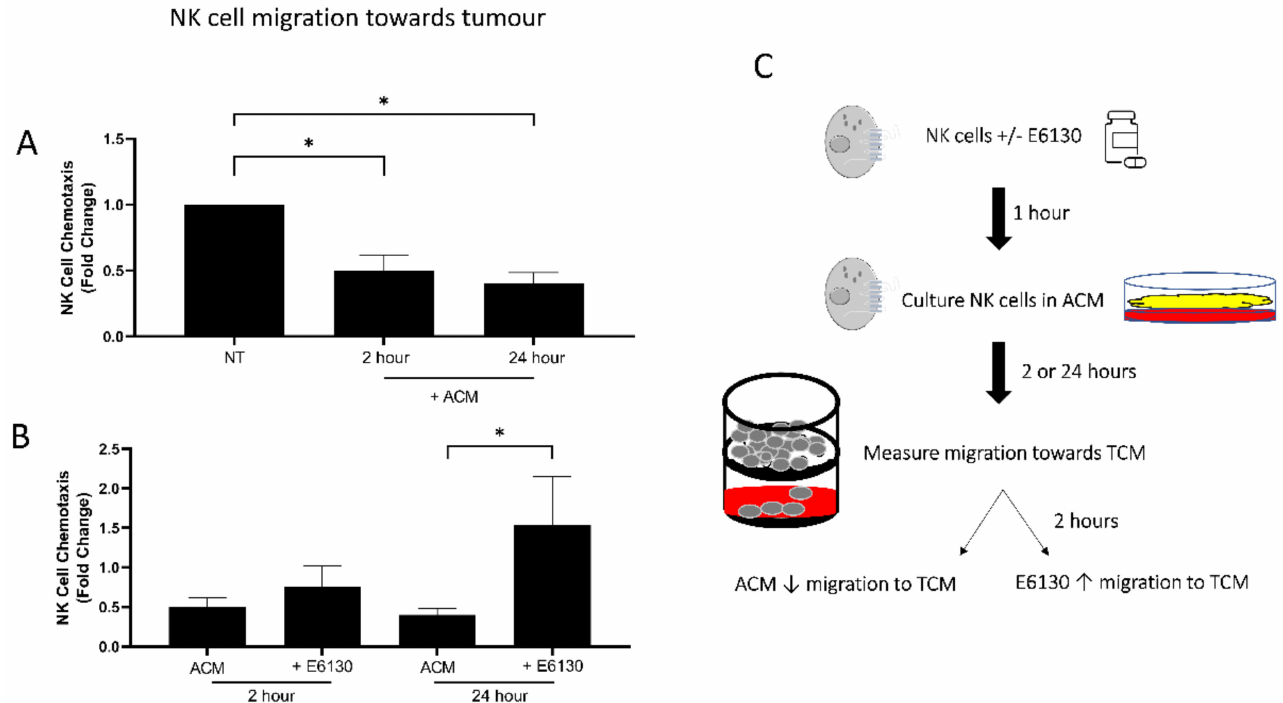
Figure 2. Soluble mediators in OAC patient-derived omentum significantly impede NK cell migration towards OAC tumour, which can be restored by CX3CR1 antagonist E6130. ( A ) Bar chart showing the fold-change migration of NK cells to OAC patient-derived tumour conditioned media (TCM) relative to no treatment (NT) or treatment with adipose conditioned media (+ACM) for 2 h or 24 h ( n = 3–4). ( B ) Bar chart showing the fold-change migration of NK cells to OAC patient-derived tumour conditioned media (TCM) relative to no treatment, following treatment with adipose conditioned media (ACM) for 2 h or 24 h with and without pre-treatment with 5 nM CX3CR1 antagonist (+E6130) ( n = 3–4). ( C ) Schematic of NK cell chemotaxis towards TCM. NK cells are pre-treated with CX3CR1 antagonist E6130 for 1 h prior to culture in ACM or left untreated. Cells are then cultured in OAC patient-derived ACM for 2 or 24 h. NK cell migration towards TCM is then measured in a transwell assay for 2 h. ACM exposure significantly decreases NK cell migration towards TCM, while